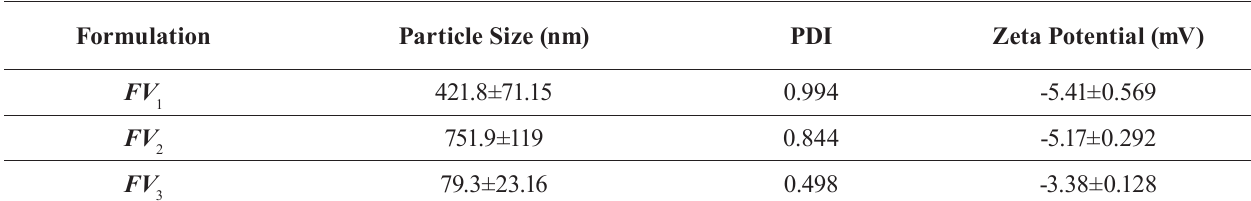
TABLE II - Particle size, PDI and Zeta potential of the VEGF-free and VEGF loaded PCL nanoparticles